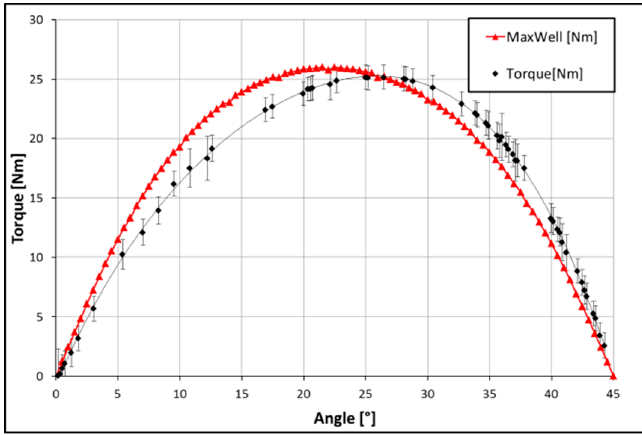
Figure 10. Comparing MAXWELL and Experiment results for Type A configuration.